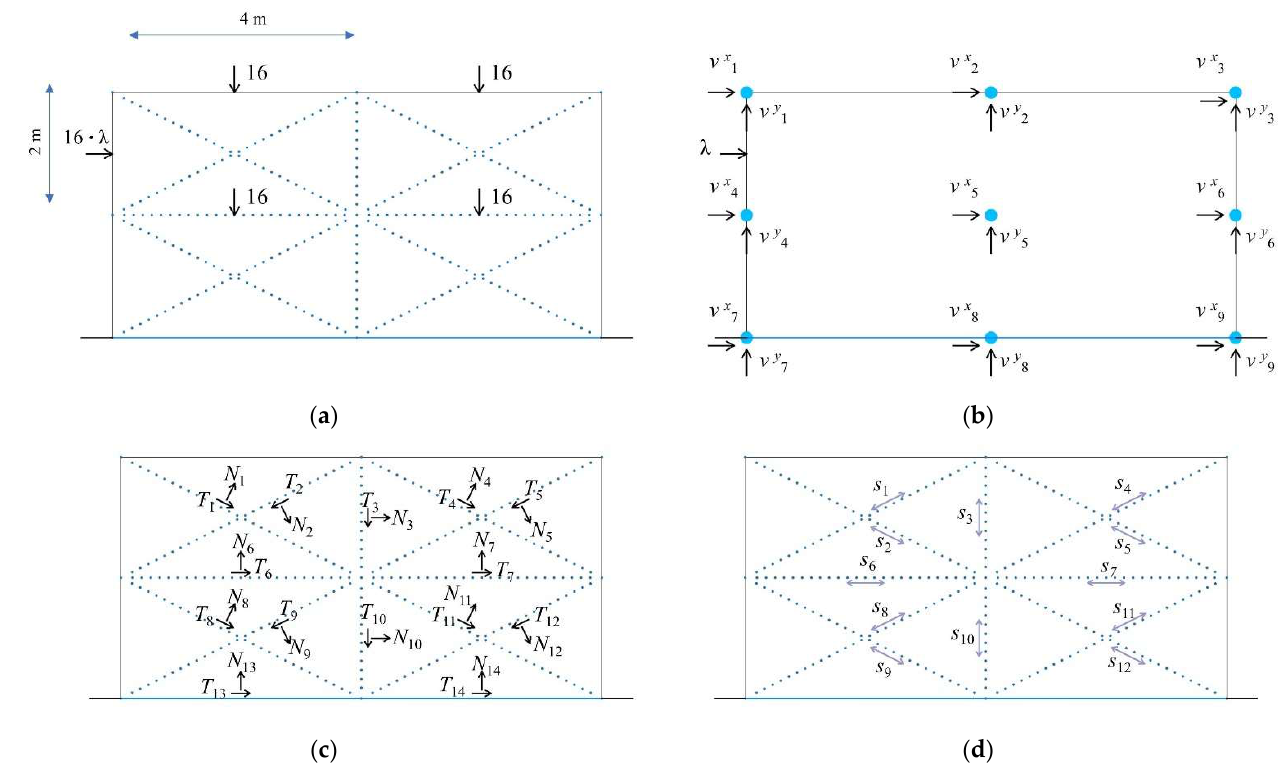
Figure 9. ( a ) Similar 2D problem to Figure 4a developed using DLO. Variables involved in the segmentation method including: ( b ) the load factor and the loads acting on the nodes; ( c ) internal forces acting on the interfaces; ( d ) the shear strength at each interface.